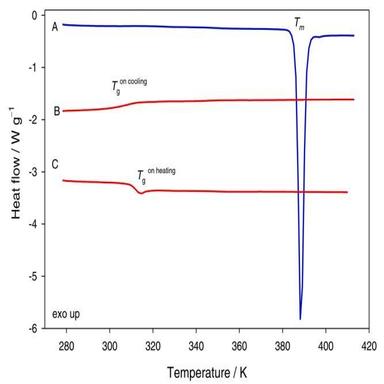
Heat-flow curves of carvedilol showing (A) 1st heating (melting of crystalline material), (B) cooling (glass transition of amorphized material) and (C) 2nd heating run (glass transition with enthalpy relaxation of amorphous material). All runs were obtained at a 10 K⋅min–1 heating rate.